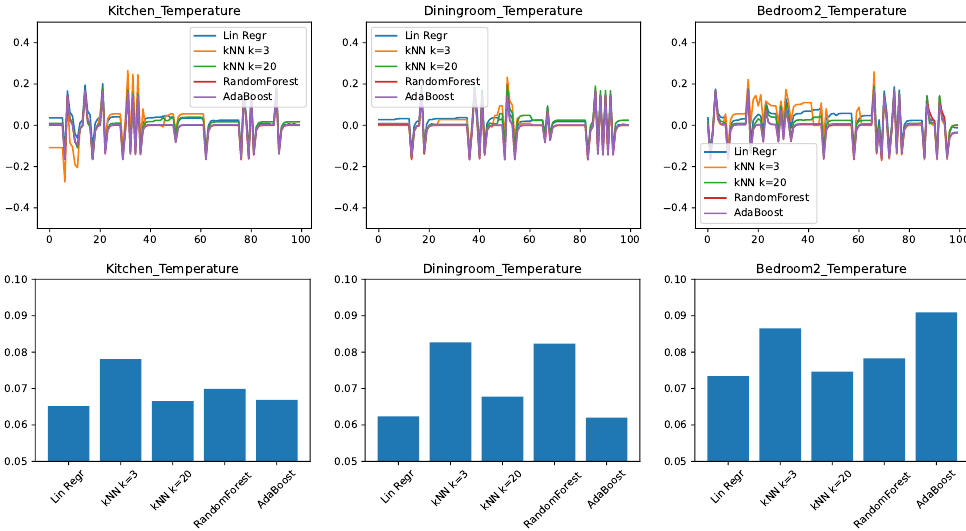
Figure 3. Comparing different regressors for temperature change prediction with a medium feature set. ( top ) Prediction error in time. ( bottom ) RMSE over the test